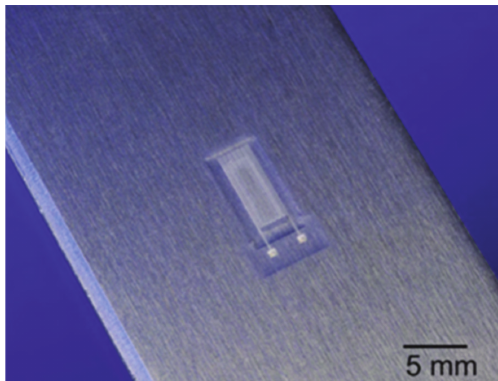
Figure 18: All Aerosol Jet printed strain gauge on aluminum substrate with polymer isolation and encapsulation, reprinted from Maiwald et al. [94], Copyright 2010, with permission from